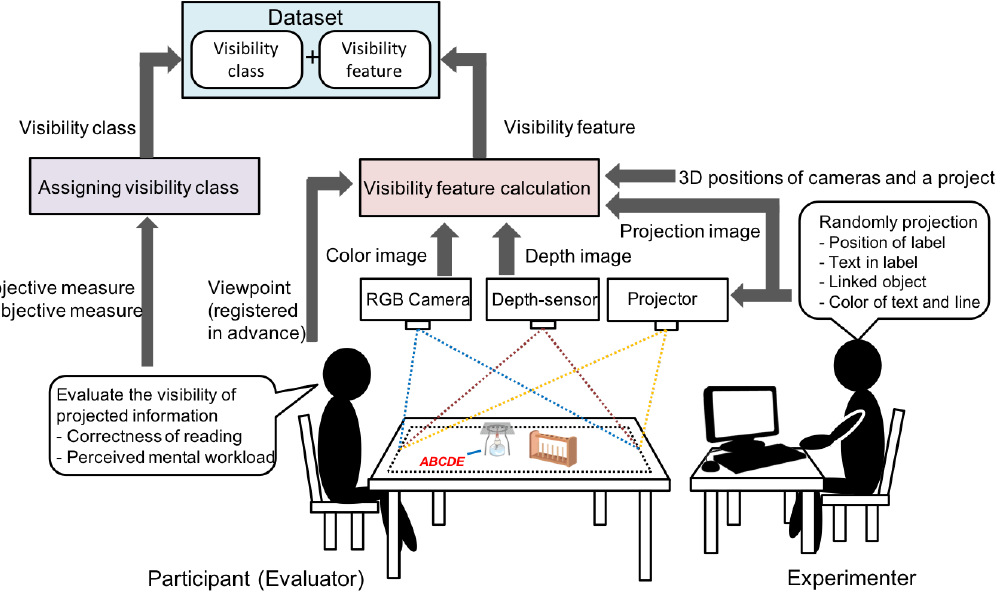
Figure 10. Data collection